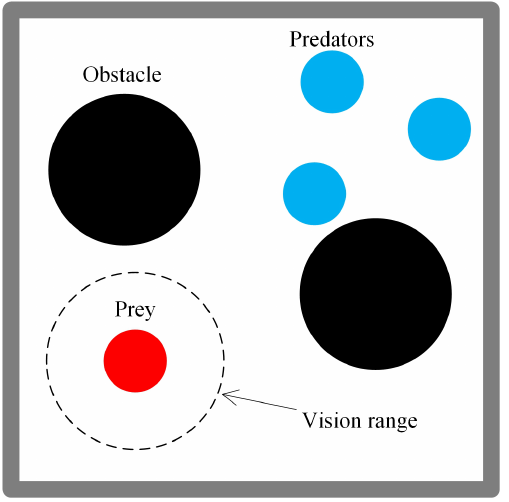
Figure 3. Predator–Prey: an adversarial multi-agent environment used in our evaluation. By designing the opponent’s fixed policy and learning the optimal response policy in the offline stage, both the agent and the opponent will directly choose the corresponding actions according to the existing policies during online interactions. Specifically, the opponent randomly selects a fixed policy in T and executes the corresponding